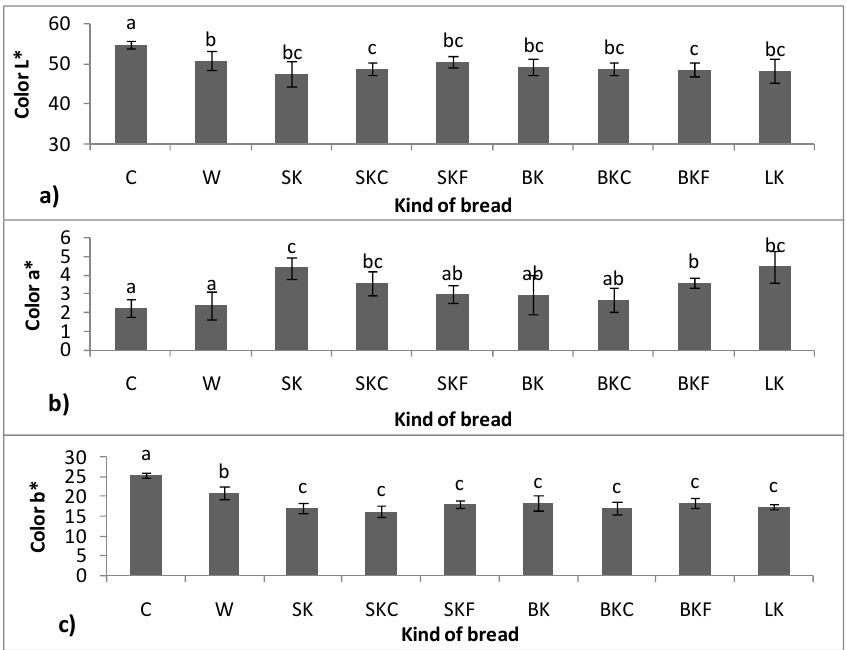
Figure 4. Color parameters (L*a*b*) of gluten-free bread with ground flaxseeds, ( a ) ColourL* value; ( b ) Colour a* value; ( c ) Colour b* value.C—control gluten-free bread, W—gluten-free bread with whole flaxseeds. SK, SKC, SKF, BK, BKC, BKF, LK—gluten-free bread with ground flaxseeds obtained